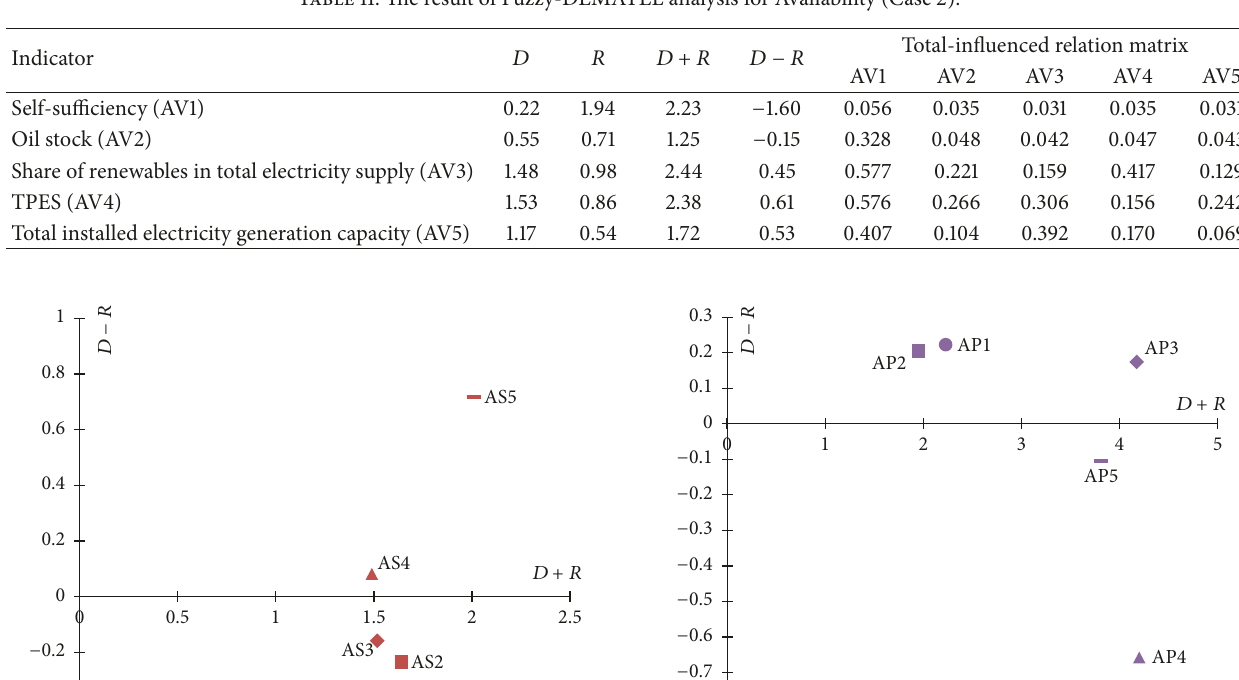
Table 11: The result of Fuzzy-DEMATEL analysis for Availability (Case 2 ).